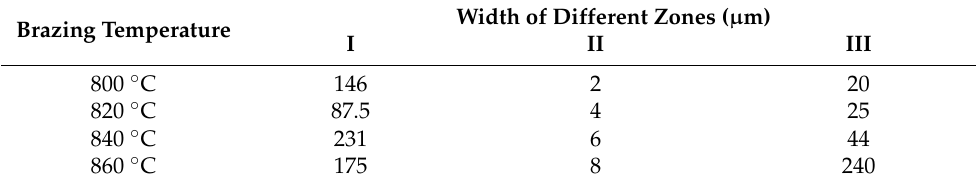
Figure 5. The microstructures of the joints brazed at different temperatures. ( a ) 800 ◦ C, ( b ) 820 ◦ C, ( c ) 840 ◦ C, ( d ) 860 ◦ C. Table 2. Width of each zone under different brazing